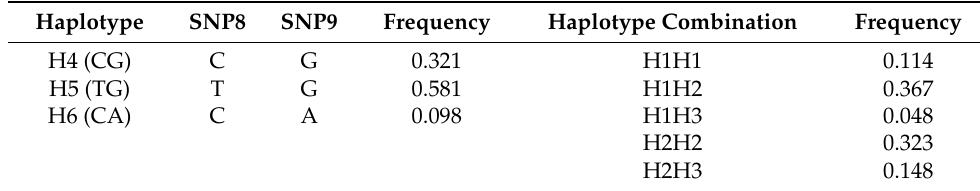
Table 4. Haplotype and haplotype combination analyses of SNPs (block2) in IGF1R